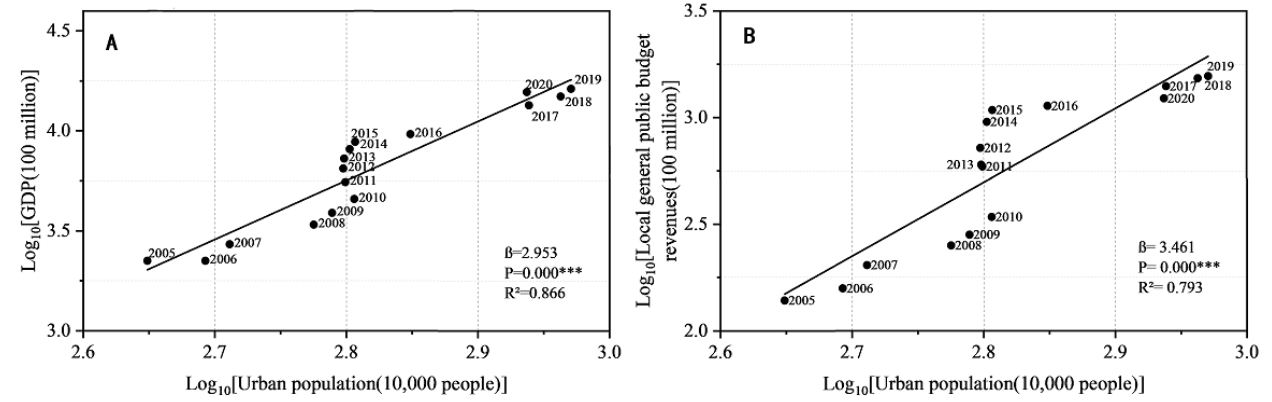
Figure 2. Temporal scaling laws of GDP and local general public budget revenues. ( A ) Temporal scaling law between GDP and urban population in Wuhan from 2005 to 2020; ( B ) Temporal scaling law between local general public budget revenues and urban population in Wuhan from 2005 to 2020; *** p < 0.001.